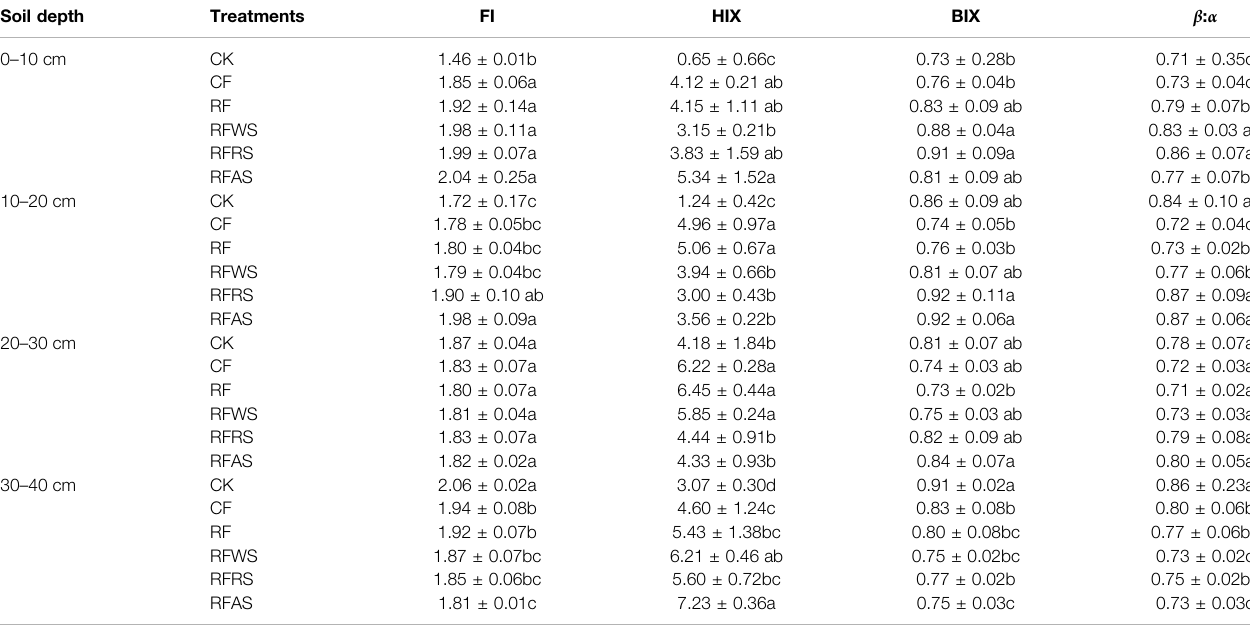
TABLE 3 | Variations of fl uorescent indices (FI, HIX, BIX, and β : α ) from soils sampled after leaching test. Soil depth Treatments β : α 0 – 10 cm